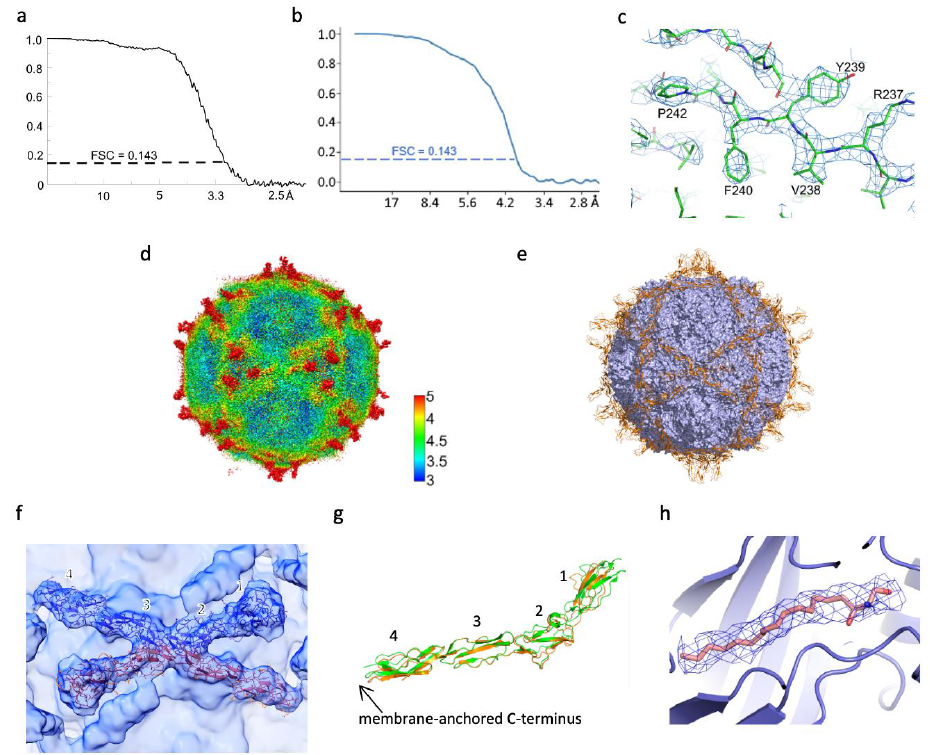
Figure 1. Overall structure of E11-DAF complex. ( a ) FSC curve of the E11-DAF complex with the threshold 0.143, the final resolution is 3.1 Å (calculated by Relion). ( b ) FSC curve of the local refined map centred at DAF with the threshold 0.143, the overall resolution is 3.9 Å (calculated by Cry- osparc). ( c ) Representative density of E11 viral capsid. ( d ) Local resolution map of E11-DAF com- plex. ( e ) Three-dimensional reconstruction of E11-DAF complex with fitted DAF shown as cartoon. ( f ) Close-up of the Cryo-EM reconstruction of the E11-DAF complex, showing density for two DAF molecules (orange and red) related by icosahedral 2-fold. Note, domains SCR 2 and 3 of these two DAF molecules clash with each other. ( g ) Superimposition of the E11 bound DAF (orange) with that determined by crystallography (green, PDB: 1OK3). ( h ) Density of the pocket factor.